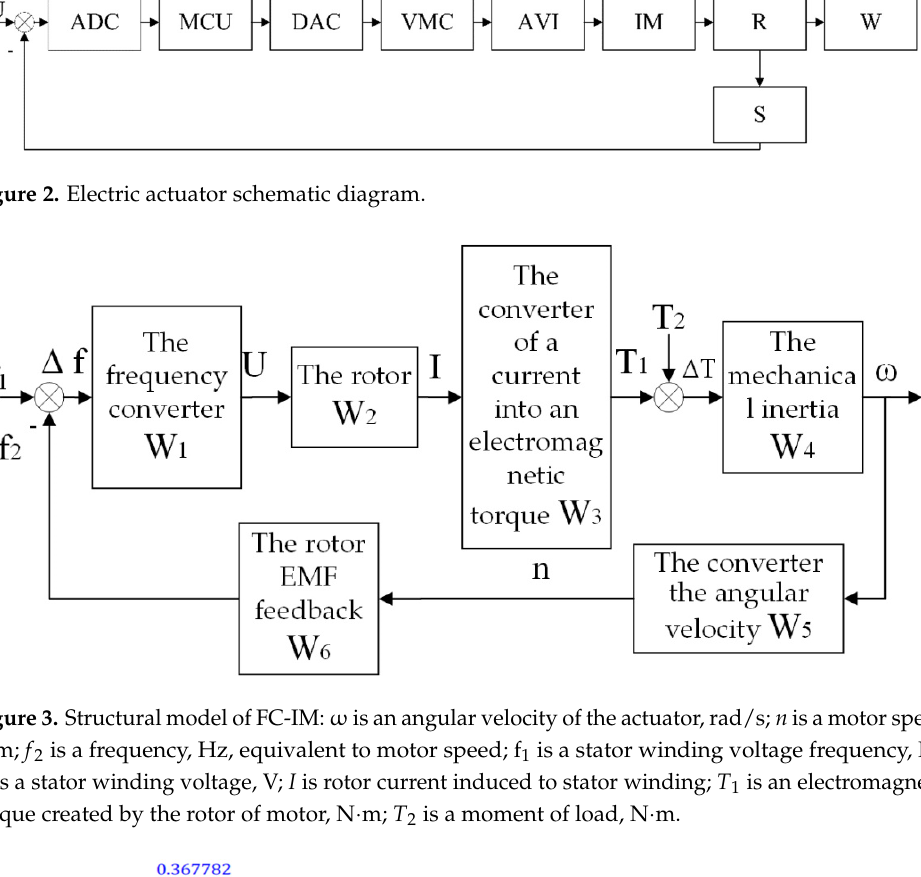
Figure 1. Structural diagram of the actuator.